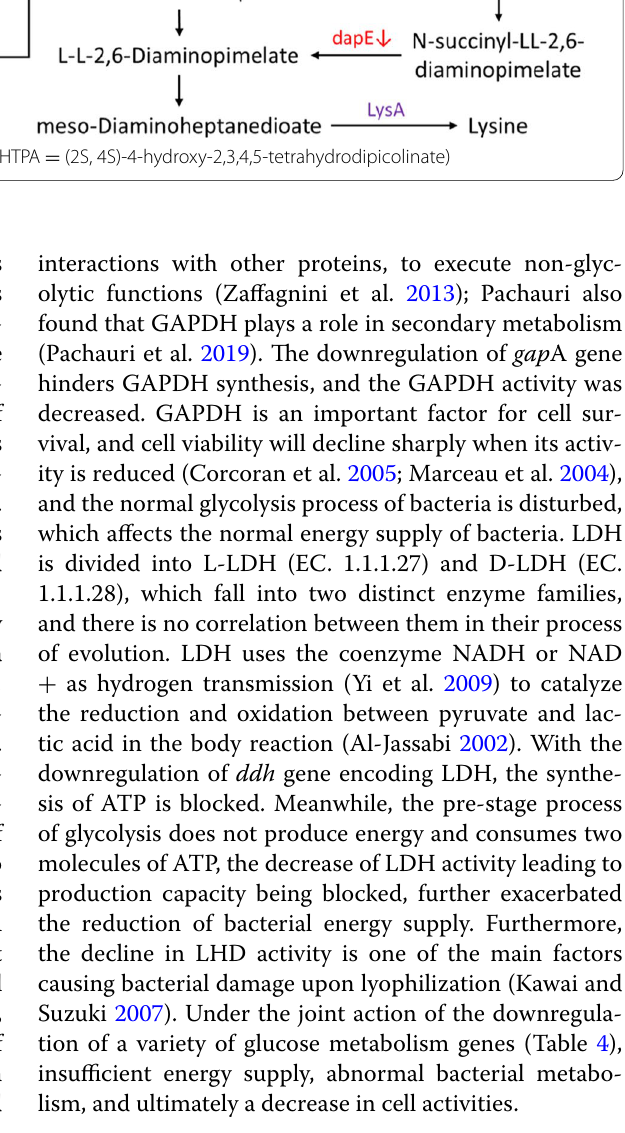
Fig. 5 DEGs related to carbohydrate metabolism and lysine synthesis. (HTPA